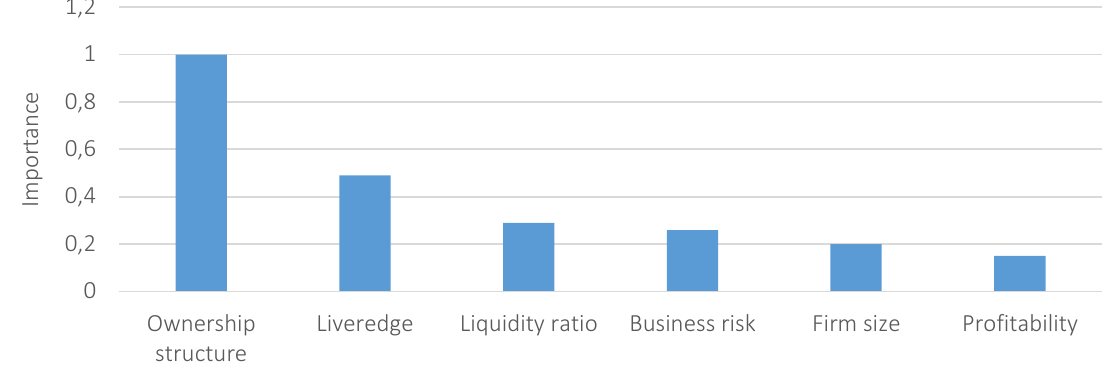
Figure 3. Importance